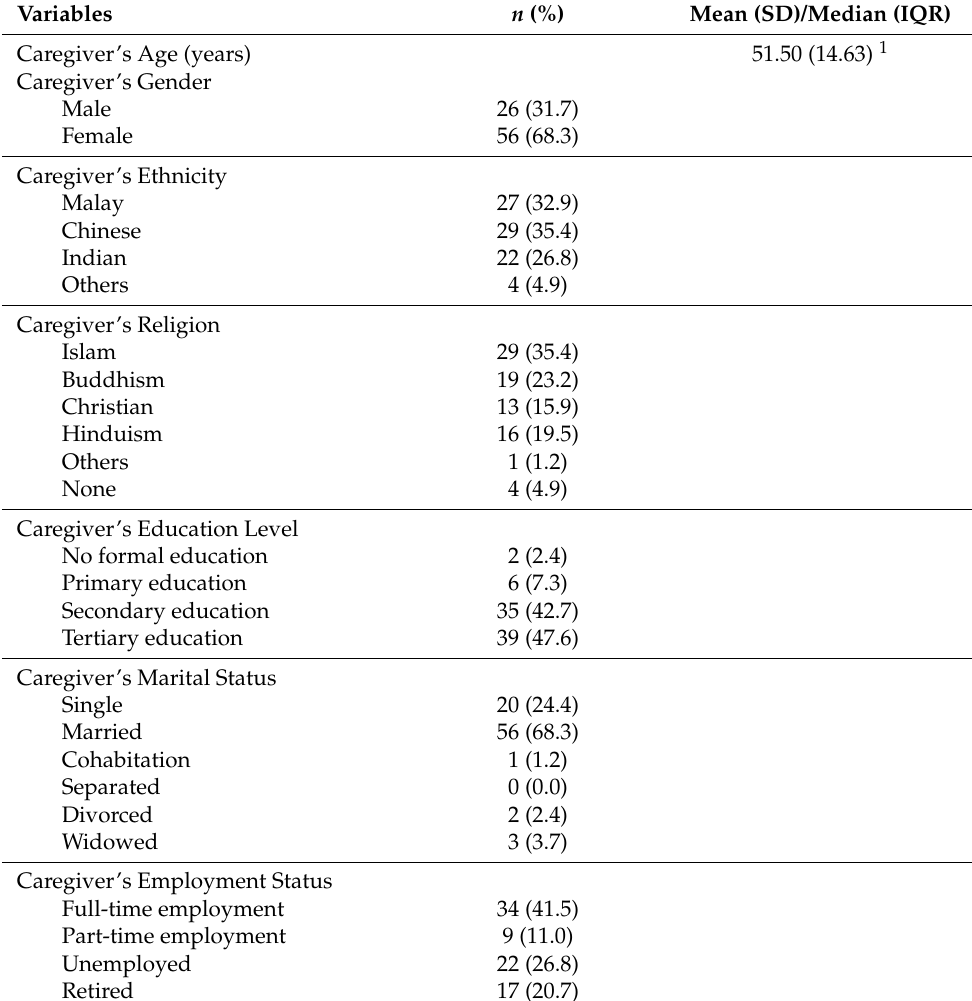
Table 2. Sociodemographics of caregivers of